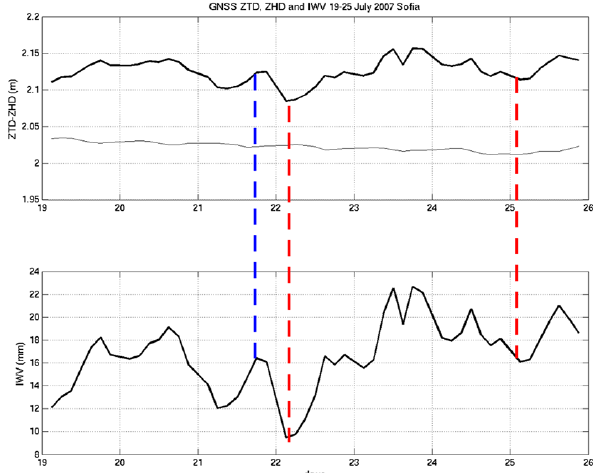
Figure 3. GNSS meteorology: ZTD, ZHD and IWV at station SOFI during the 2007 heatwave from 19 to 25 July. (a) Zenith total de- lay (ZTD), zenith hydrostatic delay (ZHD) in m, and (b) integrated water vapour (IWV) in mm. The diurnal cycle of IWV with an in- crease in the afternoon hours and a minimum in early morning is seen